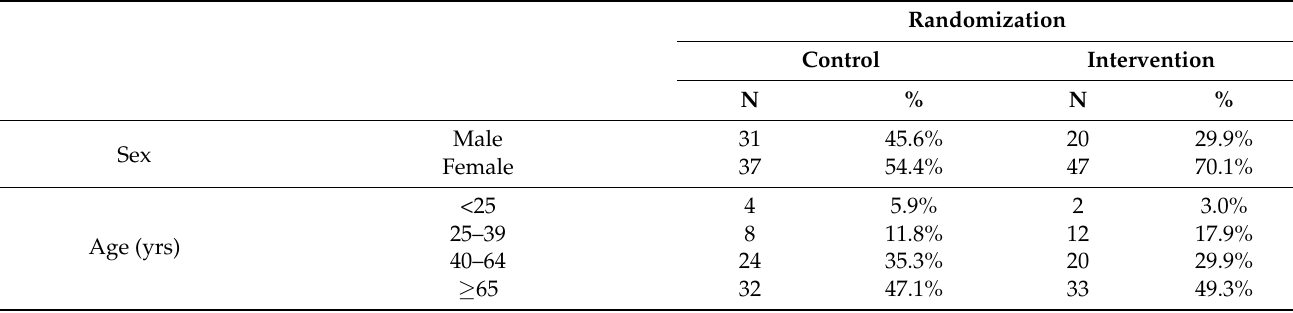
Table 1. Sociodemographic and health characteristics for 135